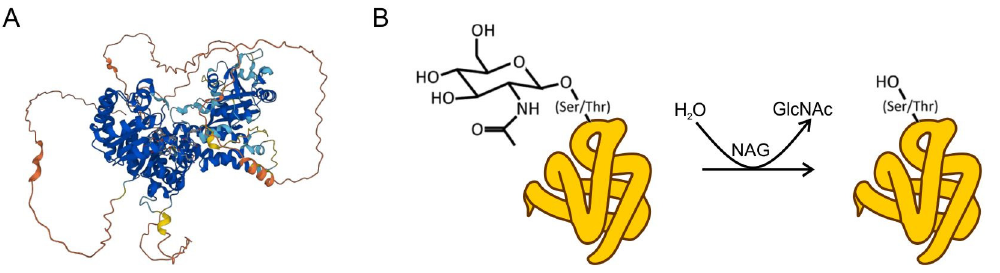
Figure 1. ( A ) Structure of NAG, as predicted by the AlphaFold protein structure database [32]. ( B ) NAG catalyzes the reversible hydrolysis of the attached GlcNAc structure.